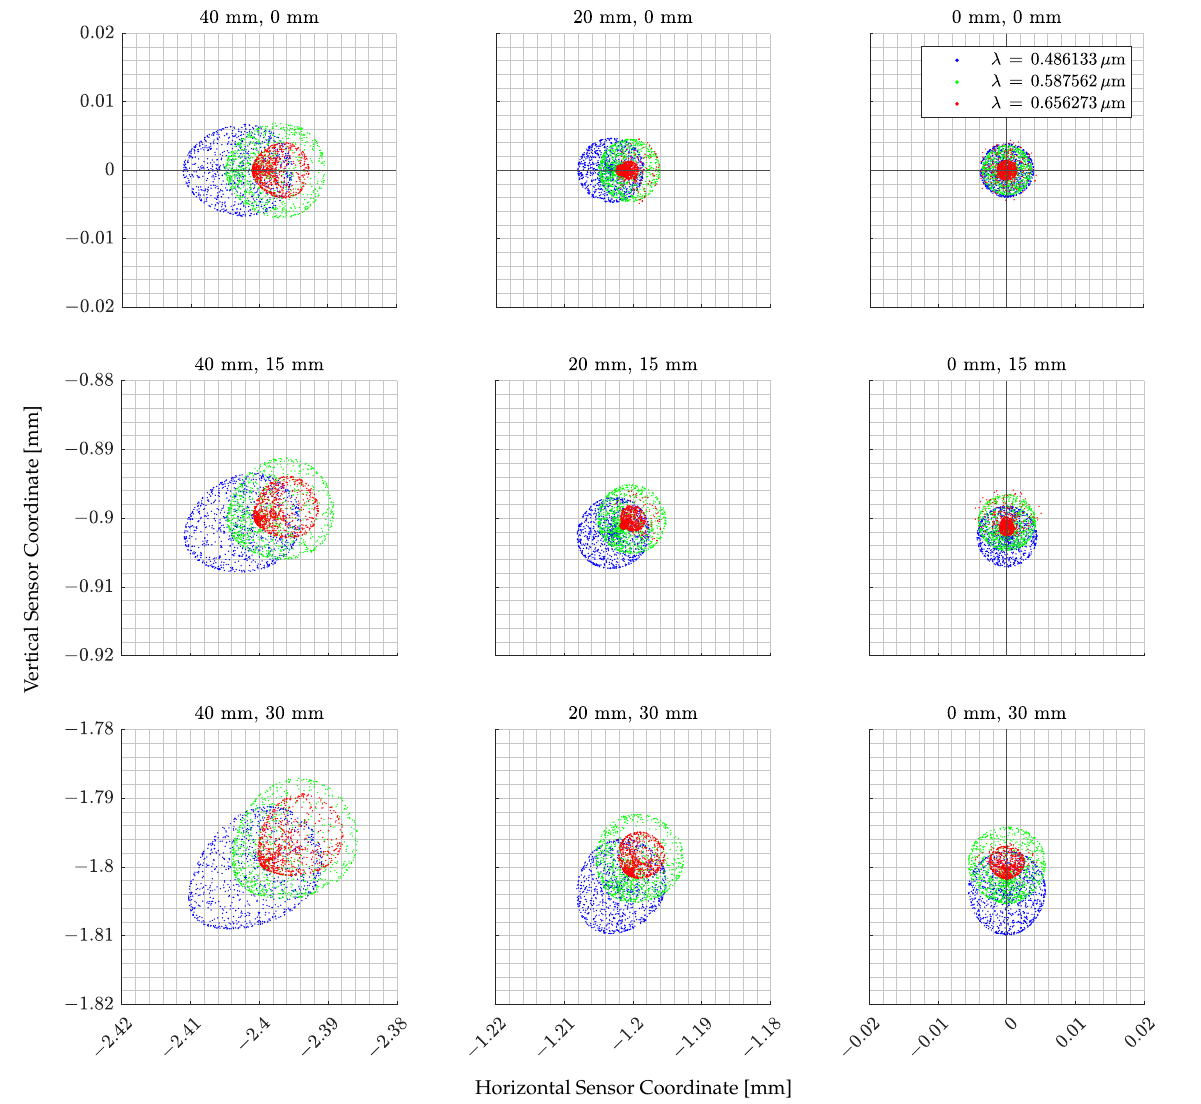
Figure 8. Spot diagram from Zemax ® . Each plot represents a portion of the camera sensor whose axes ticks are reported on the right and bottom parts of the image for the vertical and horizontal sensor coordinates, respectively. The vertical and horizontal lines show the image axes centered in the camera sensor’s geometrical center. The spot colors are associated with different wavelengths reported in the upper-left legend. The numbers over each plot define where the ray beam is generated on the